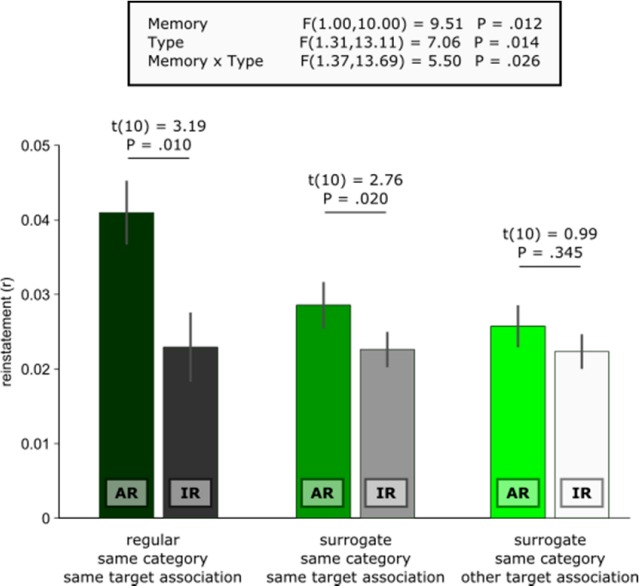
DOI:
http://dx.doi.org/10.7554/eLife.17397.015